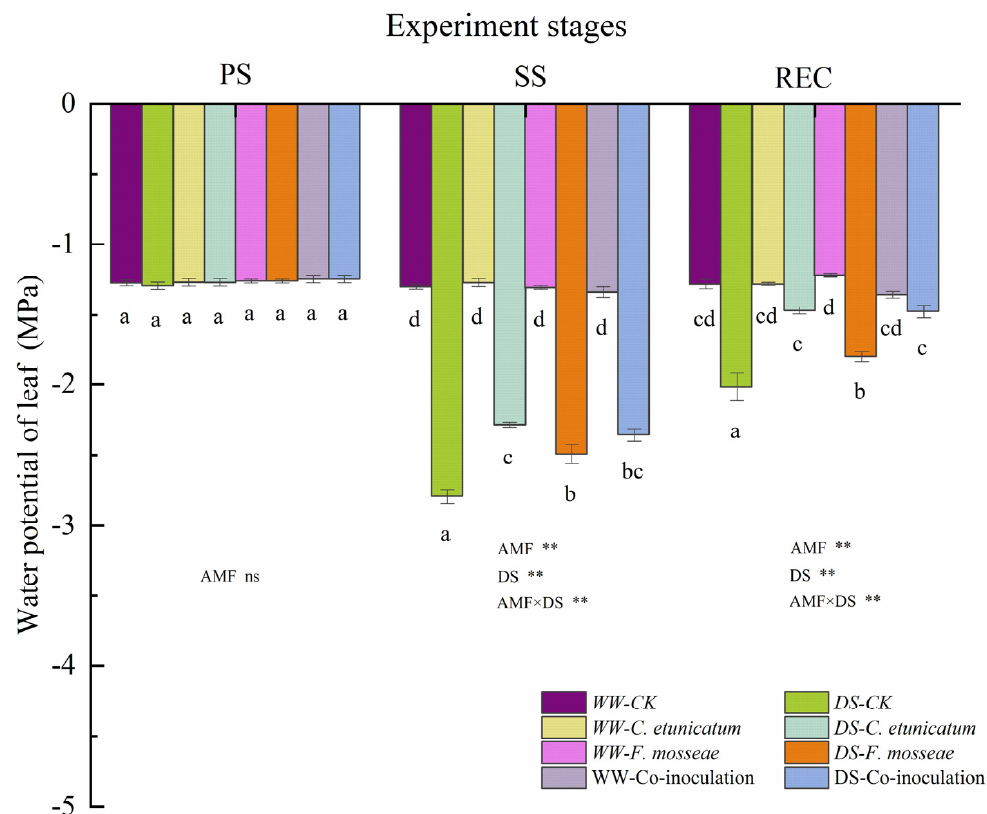
Figure 2. Effect of arbuscular mycorrhizal fungus (AMF)on the water potential of C. migao seedlings measured at different experiment stages. Different letters (a, b, c, d) indicate a significant difference in Tukey’s post hoc test (** p < 0.01; ns, not significant) between all treatments. PS: prior stress, SS: subjected to drought stress; REC: rewatered; DS: drought stress; WW: well − watered. CK, non − AMF control; C. etunicatum , plants inoculated with C. etunicatum ; F. mosseae, plants inoculated with F. mosseae; Co − inoculation, plants inoculated with F. mosseae and C. etunicatum Values are expressed as the mean ± SE ( n = 6, which are treatment replicates).